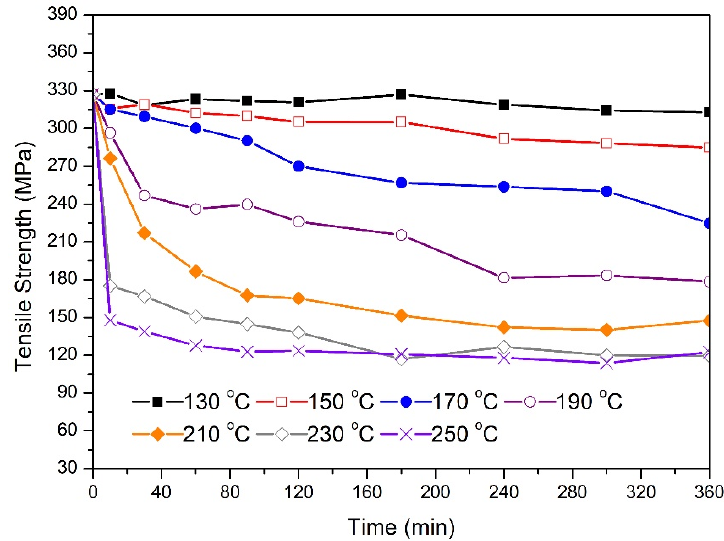
Figure 2. Changes in tensile strength as a function of the annealing time for 1.7 mm samples at the specified temperature.